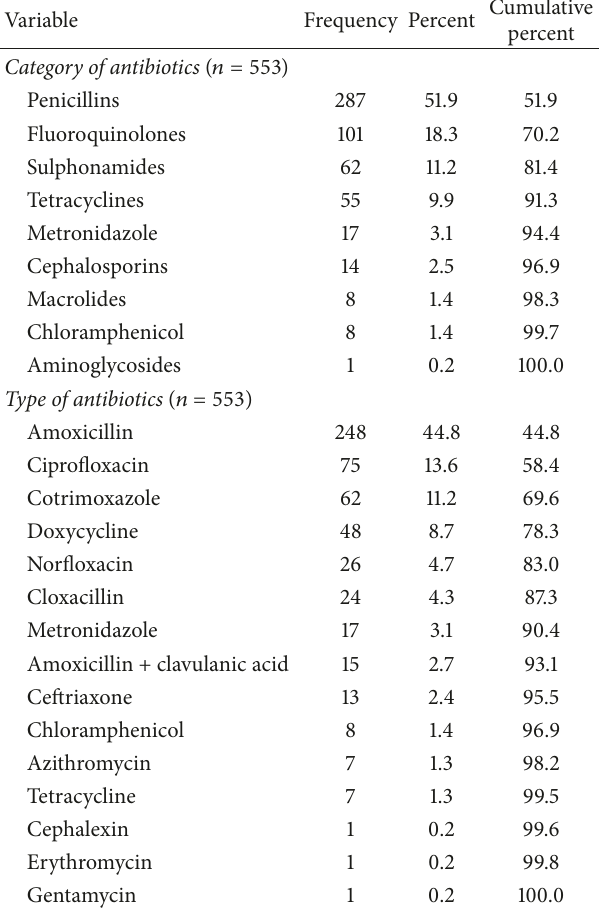
Table 3: Frequently prescribed type and category of antibiotics at health centers in Addis Ababa, January 1–December 31, 2016.